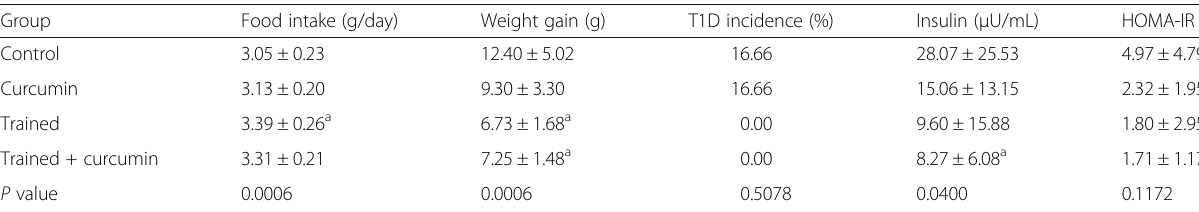
Table 1 Food intake, weight gain, T1D incidence, insulin level, and HOMA-IR after the 20-week experimental protocol